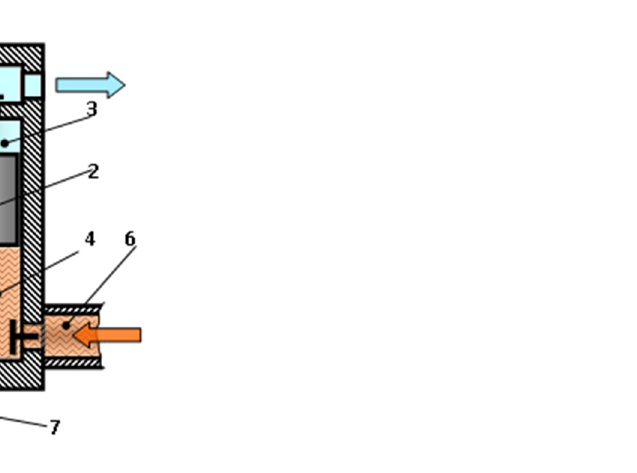
Figure 1. Construction diagram of piston hybrid power machine (PHPM). (1—cylinder; 2—piston; 3,